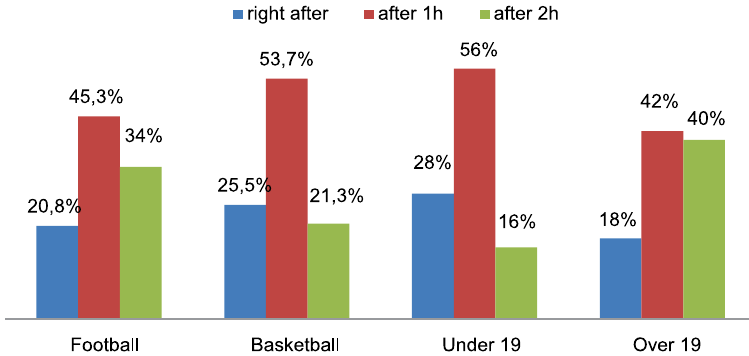
FIGURE 4. Time of consumption of meal after the training per type of sports and age